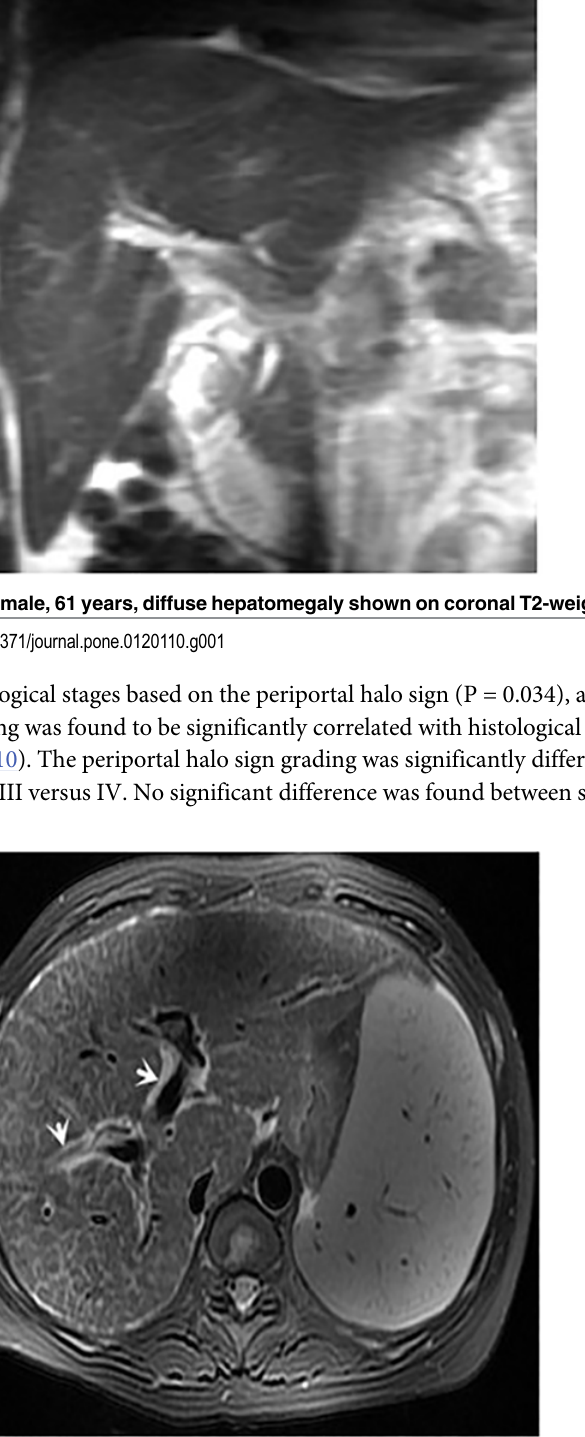
Fig 2. female, 42 years, axial T2-weighted image shows splenomegaly and demonstrates periportal hyperintensity around medium-sized portal triads ( arrows